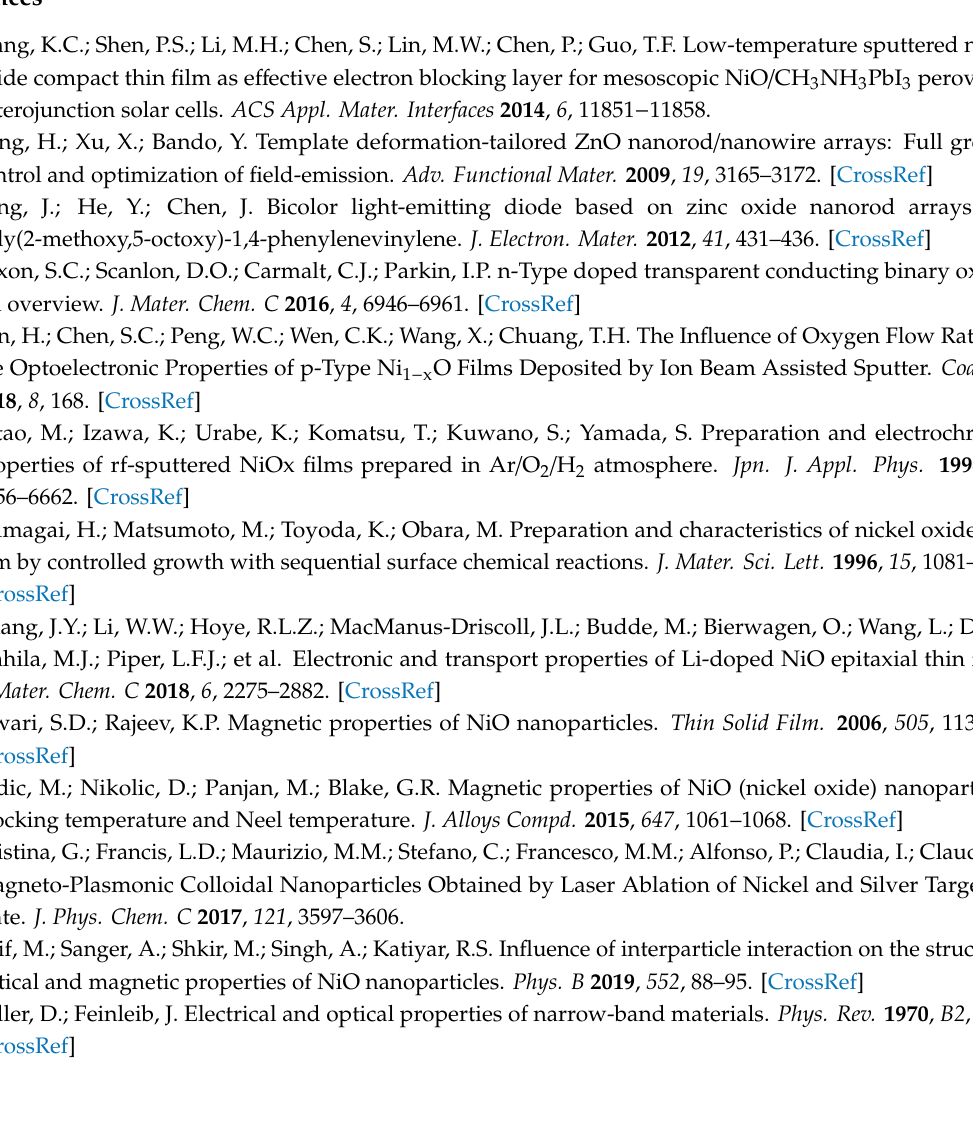
Figure S1: Cross-section SEM images of the L2NiO thin films as a function of annealing temperatures and times: (a) 400 ◦ C for 1 h, (b) 400 ◦ C for 3 h, (c) 500 ◦ C for 3 h, and (d) 600 ◦ C for 3 h. Figure S2: (a) Cross-section SEM image and (b) optical transmittance spectra of the ITO thin